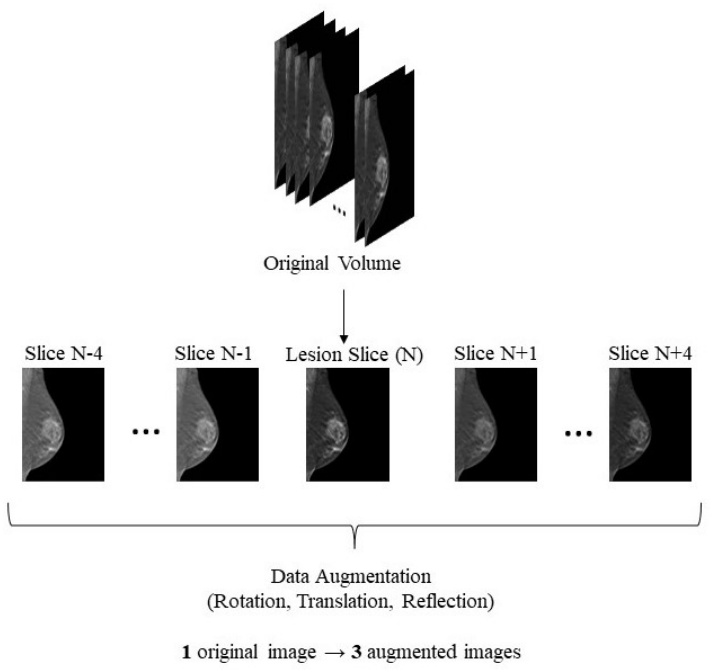
Figure 1. Data selection and augmentation—image contrast modified just for illustration purposes. From each original volume, the most representative slice and the four slices above and below were extracted. The rotation was randomly preformed in a range from − 50 ◦ to 50 ◦ , the translation could be horizontal or vertical, ranging from 1 pixel to 5% of the overall image size, and the reflection could either be vertical or